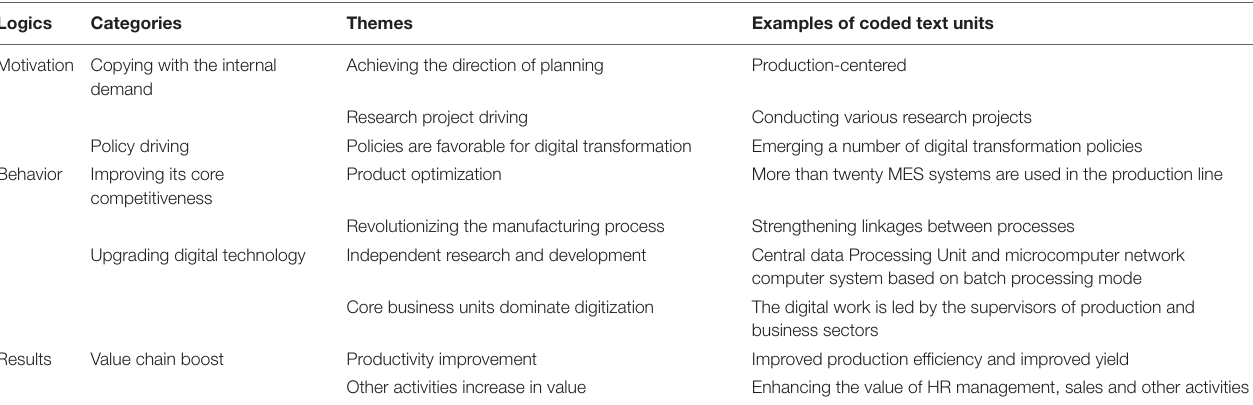
FIGURE 1 | Three phases of digital transformation. TABLE 2 | Phase 1 value chain